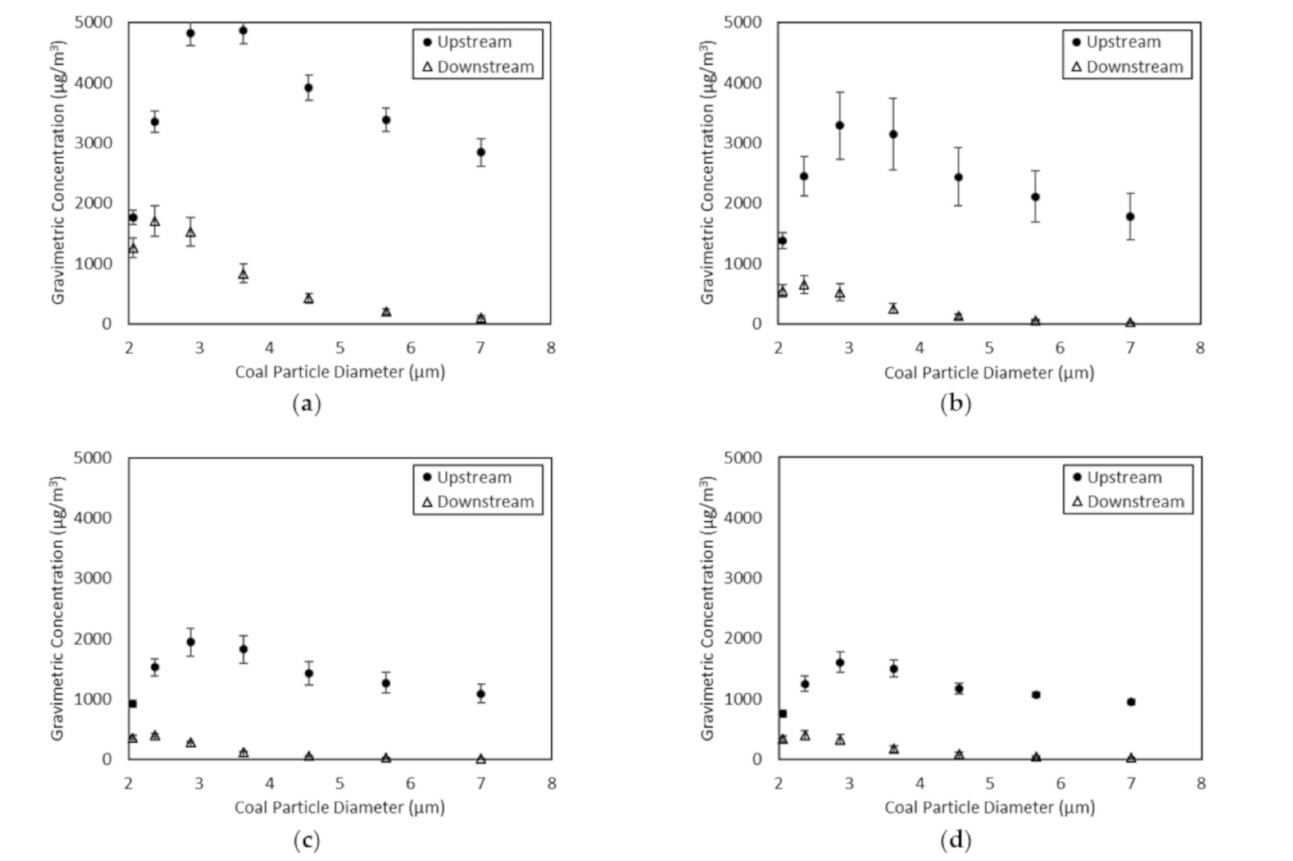
Figure 4. ( a ) Dust-concentration difference at 1.42 m 3 /s; ( b ) dust-concentration difference at 1.89 m 3 /s; ( c ) dust- concentration difference at 2.36 m 3 /s; ( d ) dust-concentration difference at 2.83 m 3 /s with water flow of 22.7 L/min.